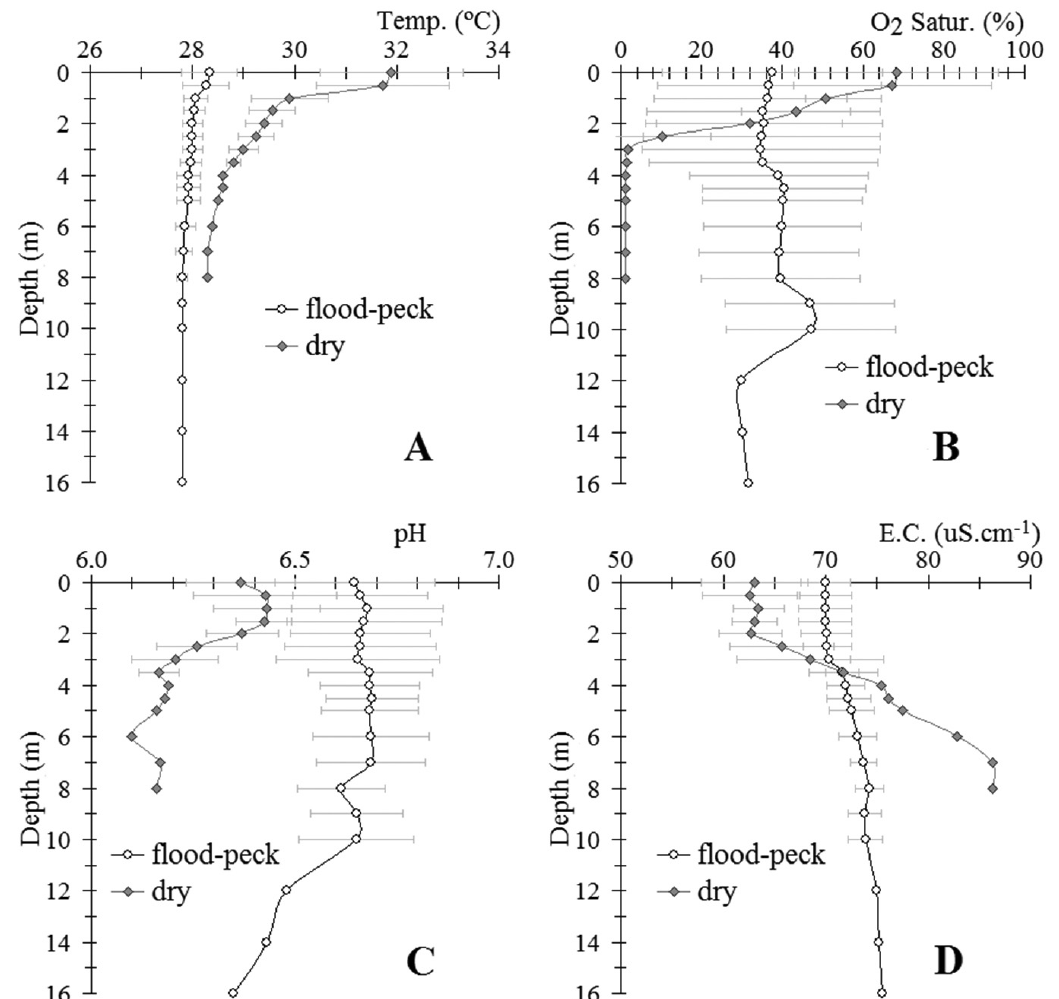
Figure 3. Vertical profile of limnological parameters for periods of flood-peck and drought of the hydrological cycle 2002-2011 in Catalão Lake - Central Amazon. Mean values with standard